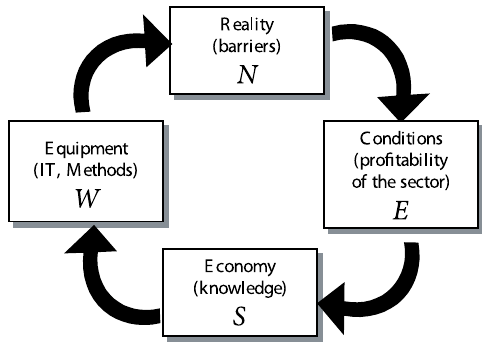
Fig. 1. Technical and economic conditions of development and utilization of IT in the construction